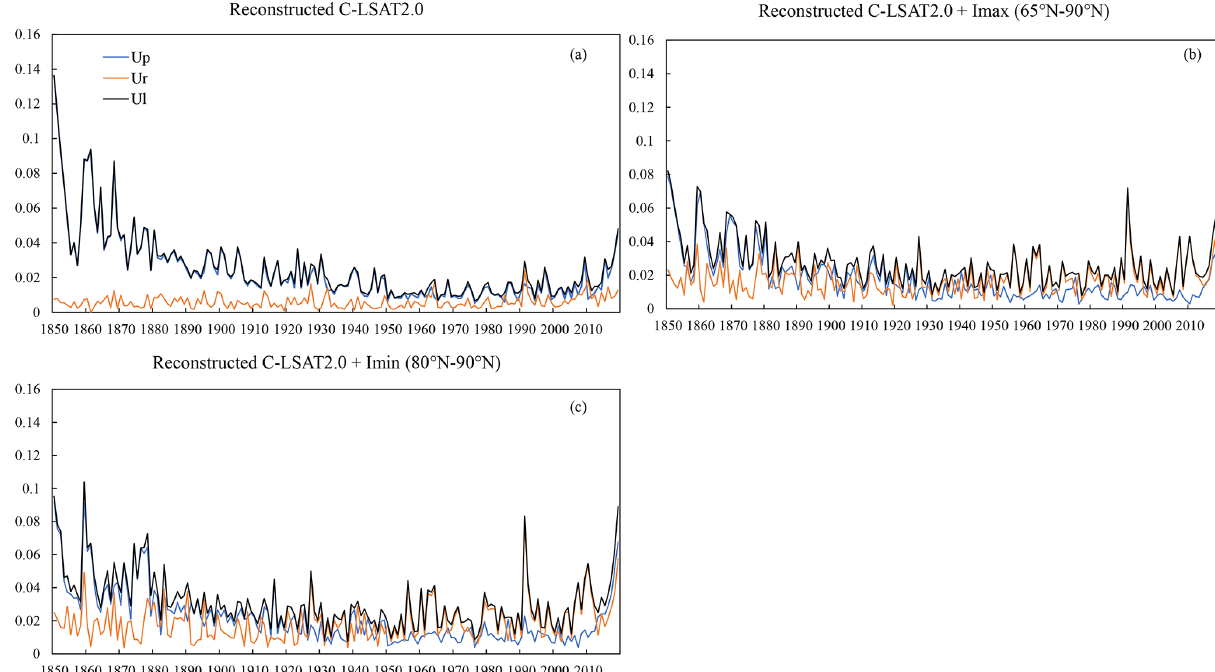
Figure 7. Parameter uncertainty, reconstruction uncertainty, and total uncertainty in three reconstructed C-LSAT2.0